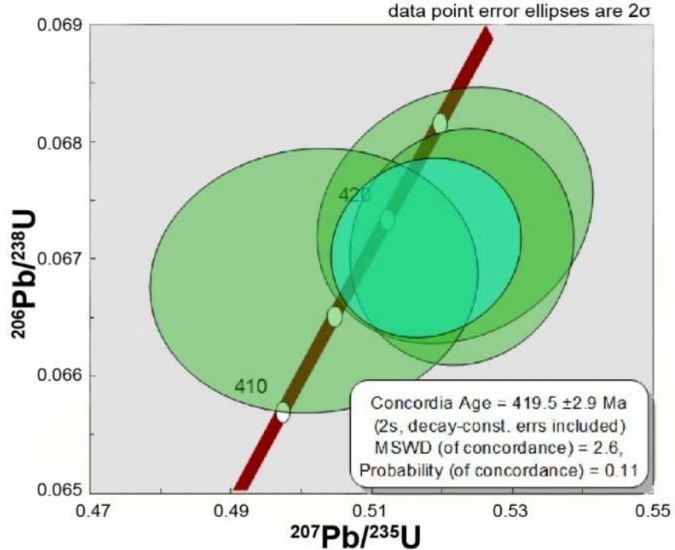
Figure 11. Transmitted light photomicrograph taken using the 10 × objective lens showing a zircon grain from the Lake George granodiorite. The dark holes in the zircon grain are ablation pits (sample LG-80-33-2017).